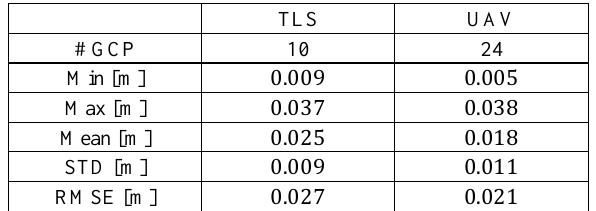
Figure 12. TLS-derived point cloud linear spacing; only points belonging to bare rock were considered.